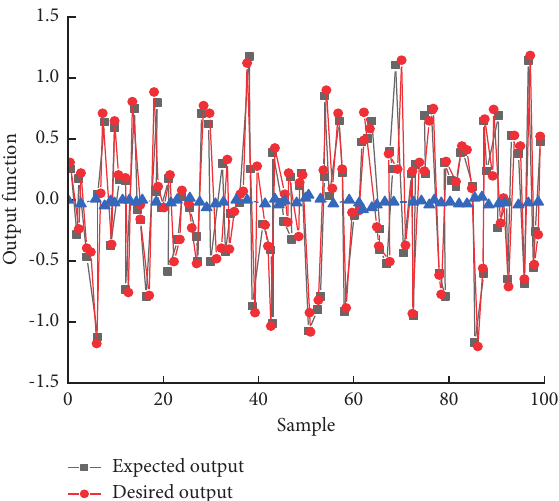
Figure 7: Neural network prediction output.